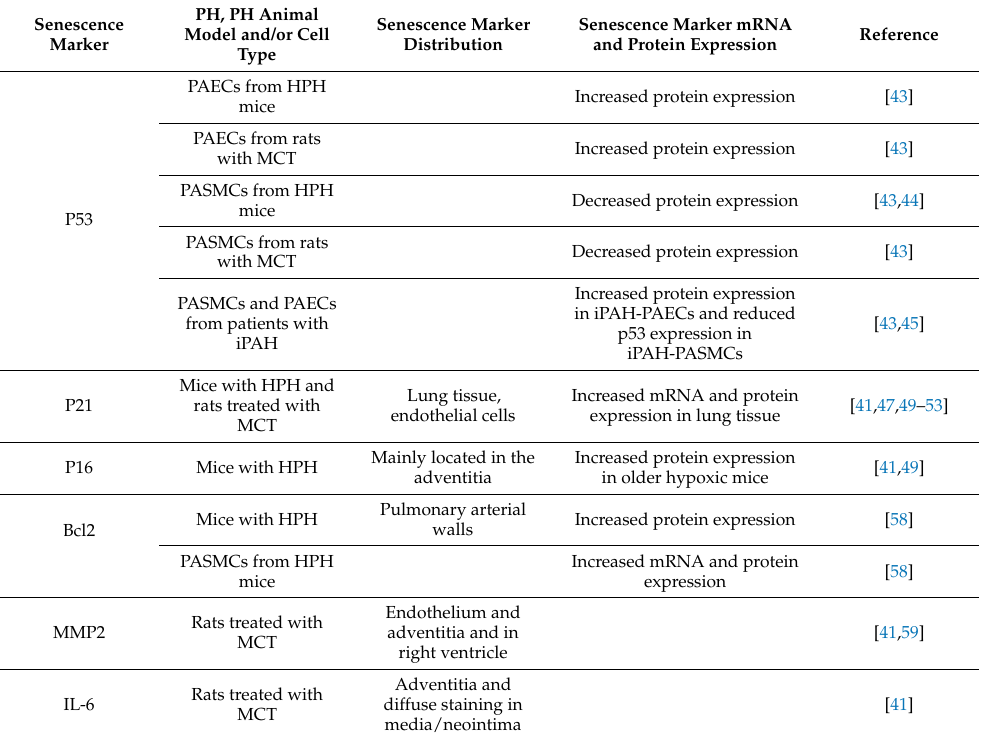
Table 3. Summary of senescence markers’ expression and distribution studies in animal models and cell types in PH.